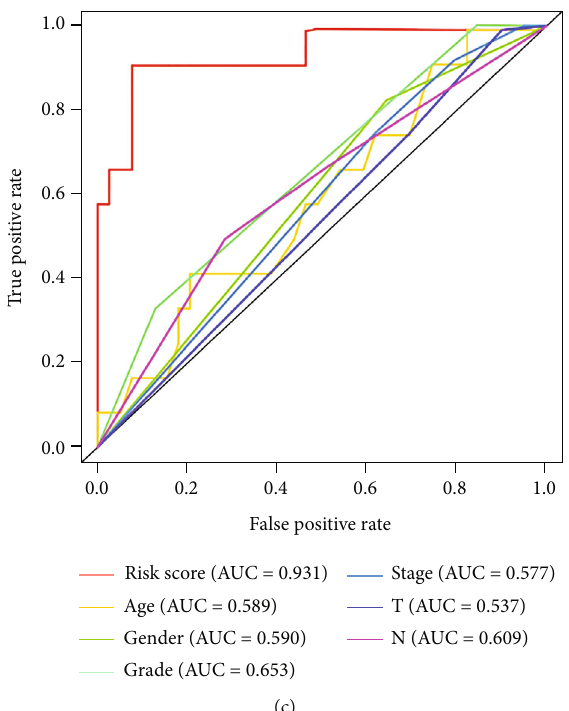
Figure 5: Forest plots of univariate (a) and multivariate (b) independent prognostic analyses of clinical trait parameters in OSCC patients. Green or red squares represent hazard ratio (HR) value, and blue solid lines represent 95% con fi dence intervals. (c) A ROC curve of the prognostic risk score model. The di ff erent colored curves represent di ff erent clinical trait parameters. AUC: area under the ROC curve. Abscissa: false positive rate ( 1 − specificity ); ordinate: true positive rate